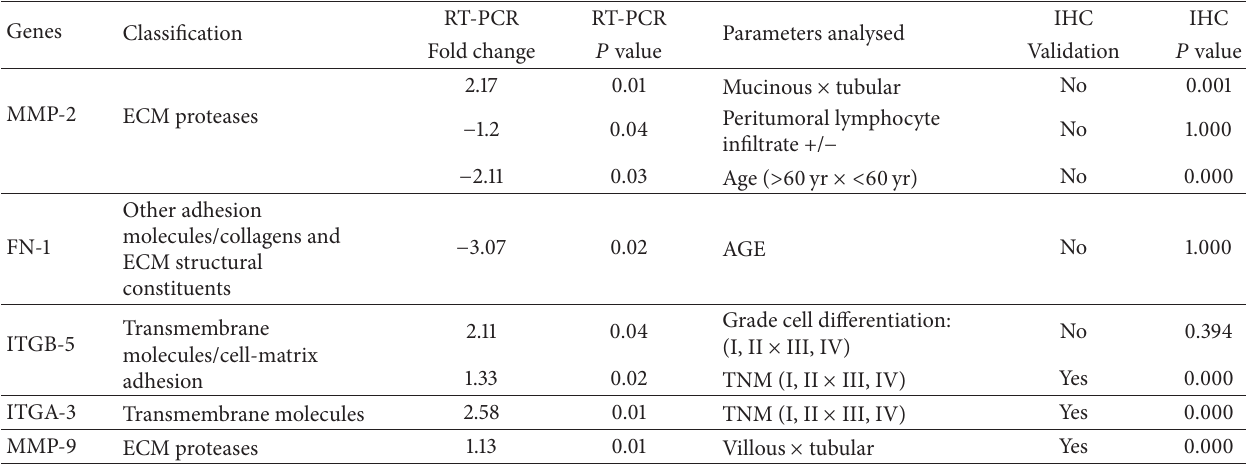
Table 12: Real-time PCR and immunohistochemistry correlation of differentially expressed extracellular matrix genes in 114 patients with colorectal adenocarcinoma, 𝑃 < 0.05